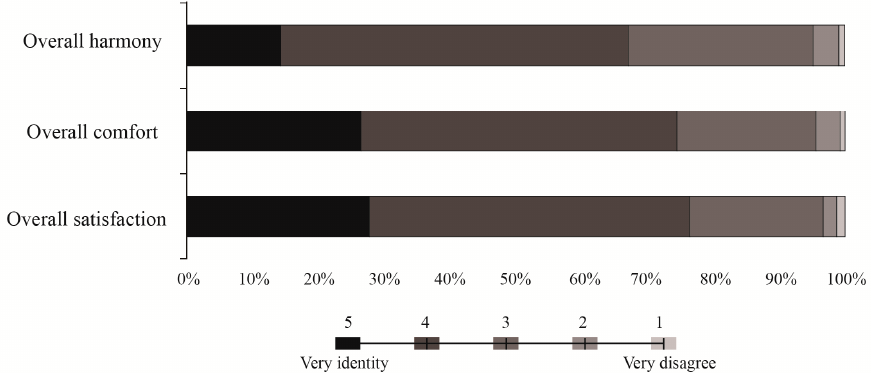
Figure 4. Overall assessment of auditory perception of soundscape.